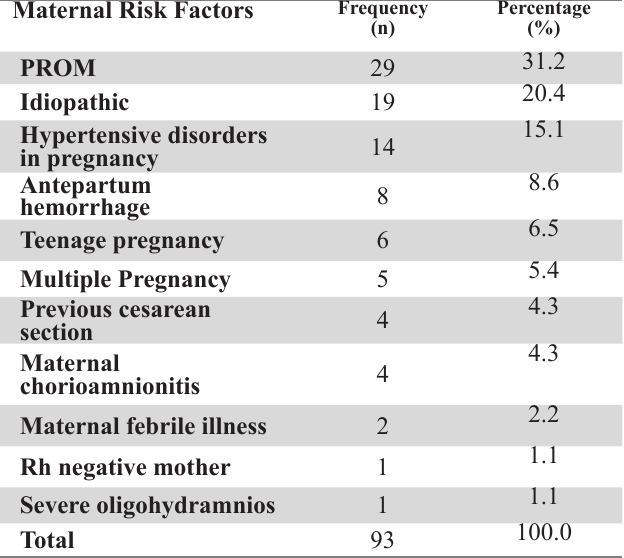
Table 2. Maternal Risk Factors for Preterm Delivery (n=93)